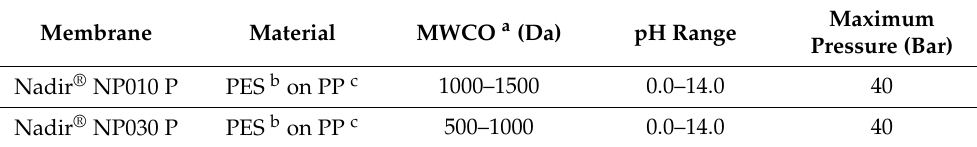
Table 1. Characteristics of the membranes used in this study, according to the manufacturers’ data. Membrane